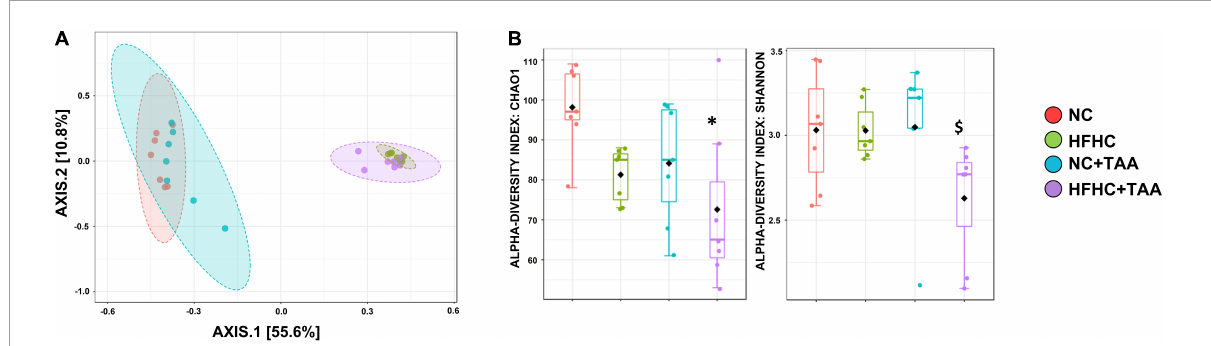
FIGURE5 Gut microbiota diversity. (A) Principal coordinate (PCoA) analysis based on Bray–Curtis distances. The PERMANOVA test showed a clear separation ( p < 0.001) of the microbiotas among the groups studied. (B) Box-and-whiskers (median and IRQ range) represents the comparison of alpha-diversity of gut microbiota using the Chao1 and Shannon indexes. The one-way ANOVA ( p < 0.016) followed Tukey’s test and the Kruskal–Wallis ( p < 0.037) followed by Dunn’s test, respectively, showed differences among groups studied ( ∗ comparison with NC group; $ comparison with all the groups). ∗ $ p <